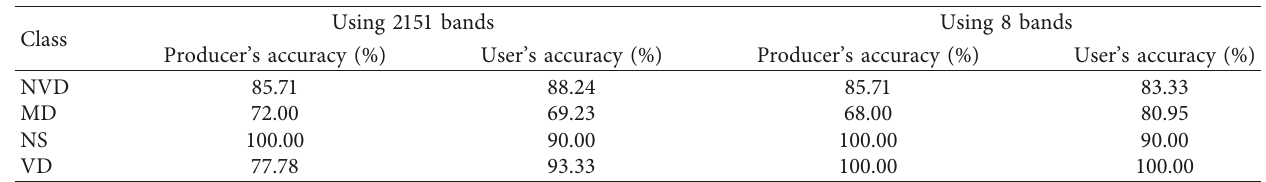
Table 8: Error matrices showing the overall accuracy and kappa for the classification of the four soil classes, nonvitrified dung (NVD), midden (MD), nonsites (NS), and vitrified dung (VD), using all variables (2151 bands) and the optimum variables (8 bands). Class